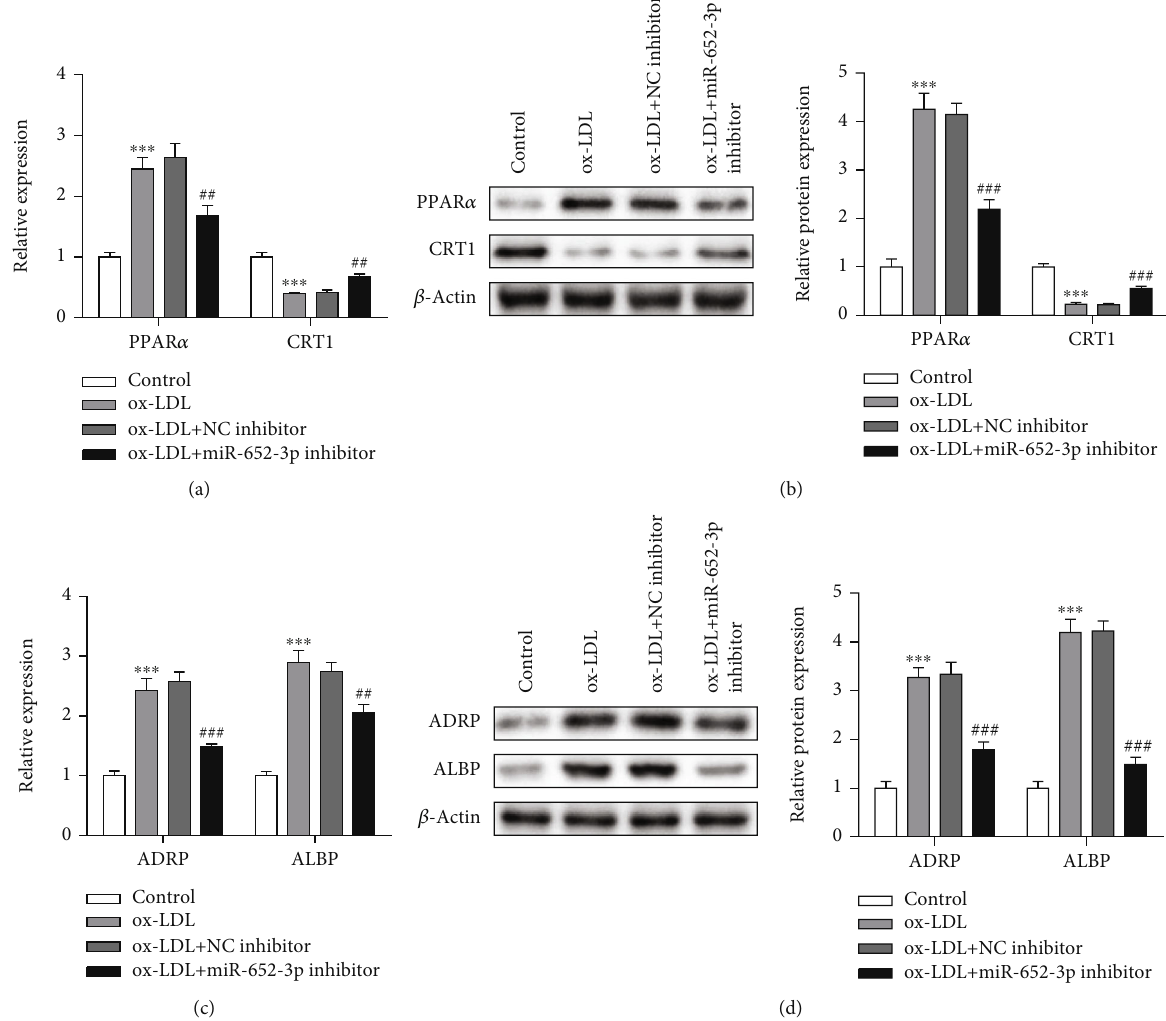
Figure 4: Knockdown of miR-652-3p reduces lipid metabolism disorder in ox-LDL-treated macrophages. (a) Q-PCR assay for detecting PPAR α and CRT1 levels. (b) Western blot assay for PPAR α and CRT1 protein expressions. (c) Q-PCR assay for detecting ADRP and ALBP levels. (d) Western blot assay for ADRP and ALBP protein expressions vs. control group ∗∗∗ P < 0 : 001 vs. ox-LDL+ NC inhibitor group, ## P < 0 : 01 , ### P < 0 : 001